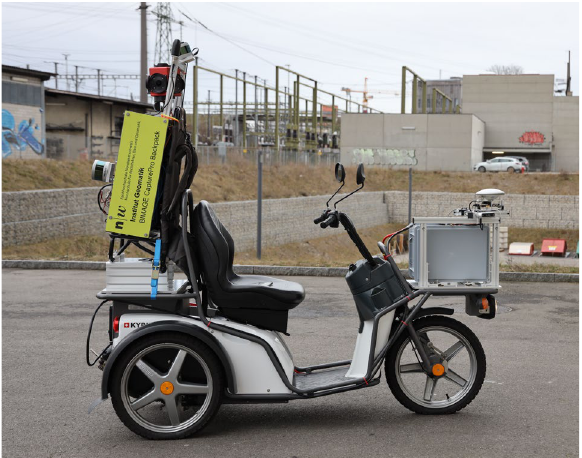
Figure 7. BIMAGE backpack mounted on our electric mobile mapping system